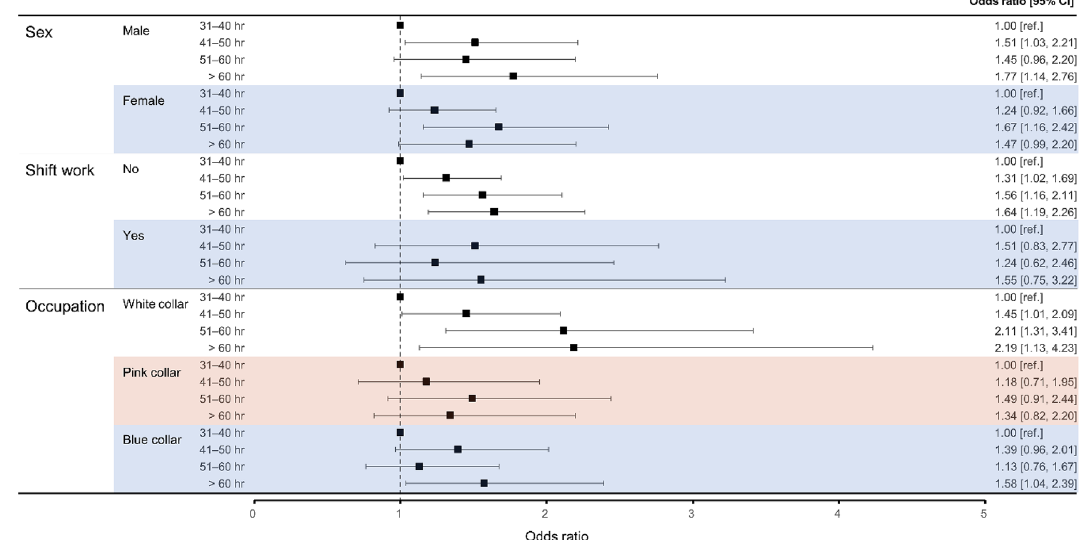
Figure 2. Associations of depressive mood with working hours according to subgroup. Model 3 was fully adjusted for age, sex, smoking status, alcohol consumption, educational level, household income, marital status, perceived health status, occupation, sleep duration, physical activity, and comorbidities. CI, confidence interval.